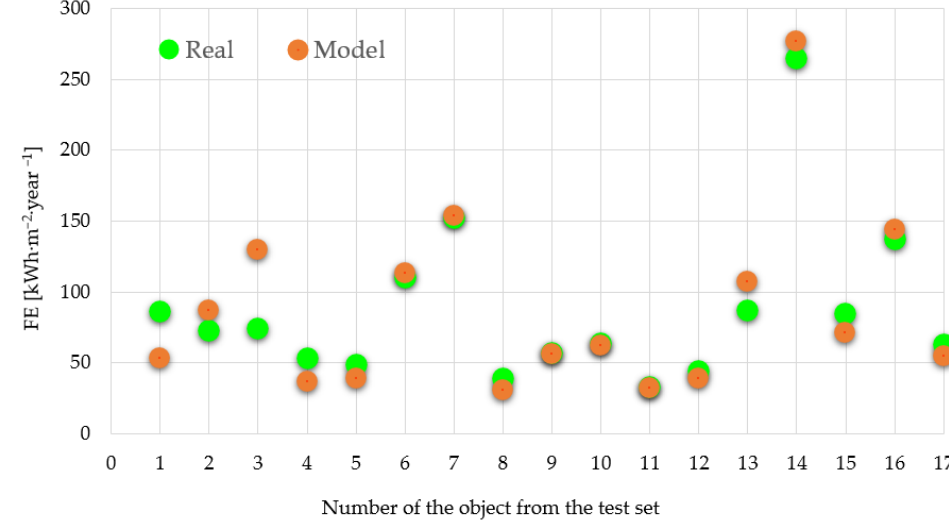
Figure 4. Comparison of the values of the FE heating demand index determined from the RST model with actual values.